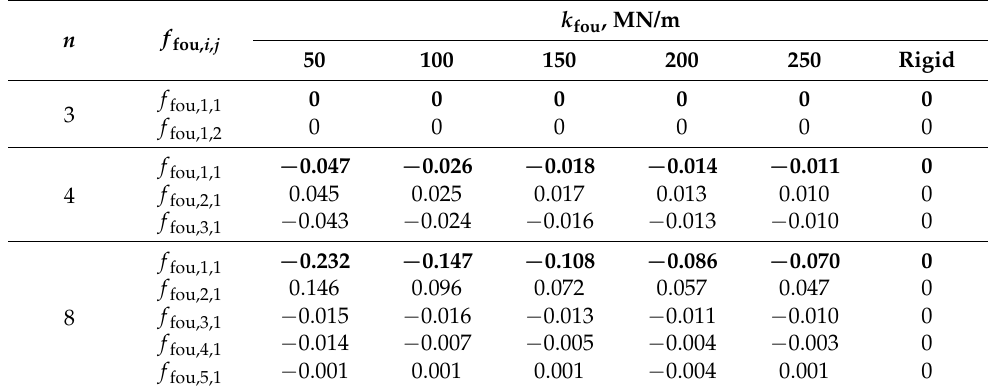
Table A12. Values f fou, i , j , [-] of the matrix f fou of support displacement forms for n = 16, k fou = 50, 100, 150, 200, 250 MN/m and k fou - rigid (elements f fou, j,j ( i = j ) are given in bold). i f fou, i ,1